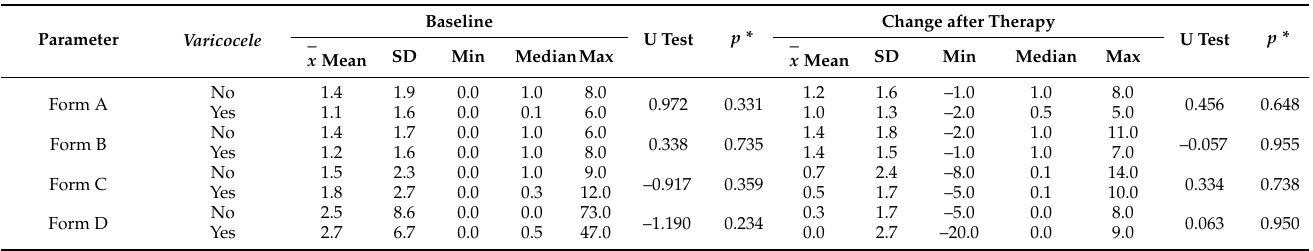
Table 7. Effects of treatment on concentrations of sperm motility forms in the ejaculate in relation to the presence of varicocele .